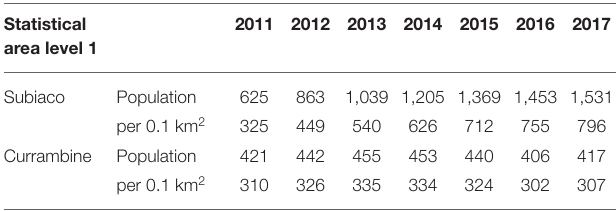
TABLE 2 | Total population and population density per 0.1 km 2 between 2011 and 2016 for Subiaco and Currambine SA1s as defined by the